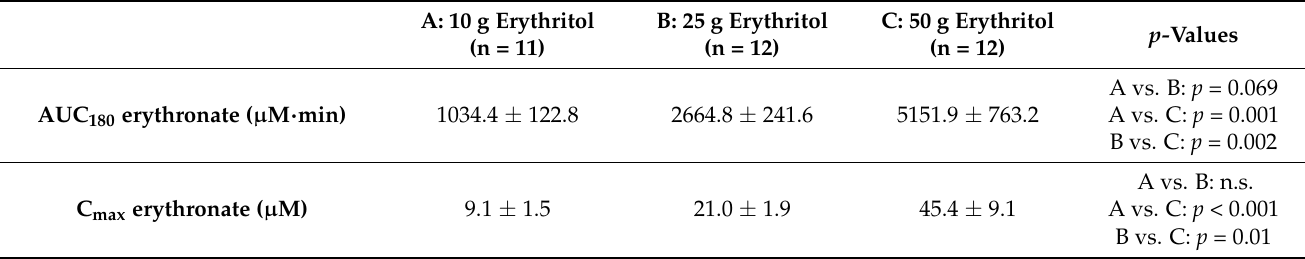
Figure 3. Dose-dependent metabolization of erythritol into erythronate. Upper part: concentration– time curves after administration of the three erythritol loads; lower part: dose–response for area under the curve from 0 to 180 min (AUC180) and maximum deviations from baseline (Cmax). Data are expressed as mean ± SEM. Table 2. Metabolization of erythritol into